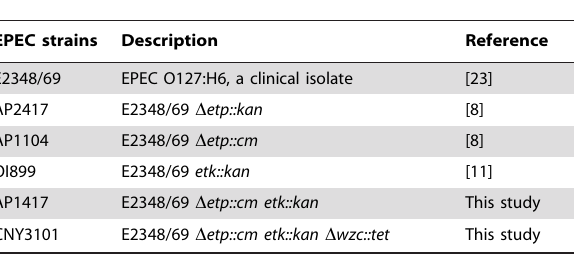
Table 2. Enteropathogenic E. coli strains.